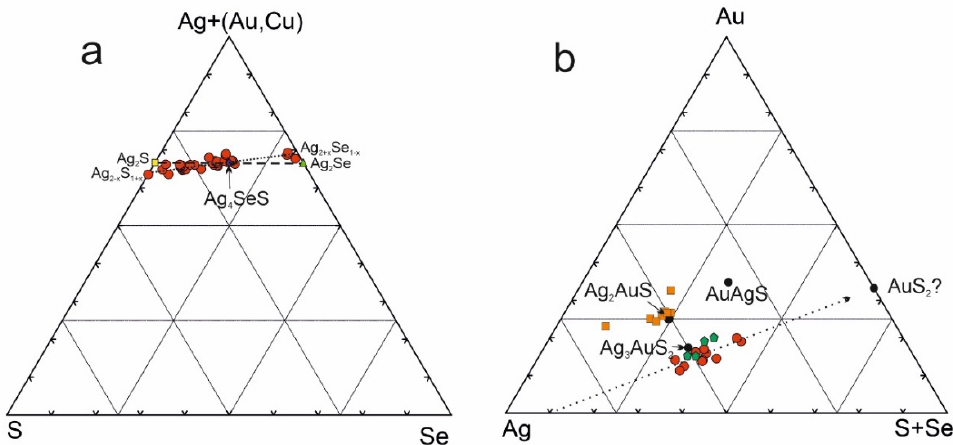
Figure 7. Composition of Ag-Au minerals: ( a ) Acanthite–aguilarite Ag 2 S-Ag 4 SeS solid solution and a few naumannite Ag 2 Se samples; ( b ) ternary graph of the Ag – Au – (S+Se) system: Ag 3 AuS 2 — uytenbogaardtite, AuAgS—petrovskaite, Ag 2 AuS—unknown phase (black dots). Green hexagons— uytenbogaardtite from the Valunistoye deposit [16]; orange squares—“Uytenbogaardtite” from the Julieta deposit [17]. Table 4. Compositions and empirical formulae of acanthite, aguilarite and naumannite, wt.%. The minerals of the pearceite-polybasite solid solution have a complex chemical formula. Their composition is presented in Table 6. A simplified formula is shown in Figure 8a. Minerals of pearceite-polybasite group according to [18] refer to pearceite, antimonpearceite, polybasite and arsenpolybasite. This phase contains Au in some analyses up to 12.2 wt.% (Table 6) and shows a slight variation between (Ag, Cu, Au) and (S + Se) (Figure 8a). The total amount of As and Sb vary from 1.66 to 1.91 apfu; both Sb-rich varieties (polybasite) and As-rich varieties (pearceite) are shown in (Figure